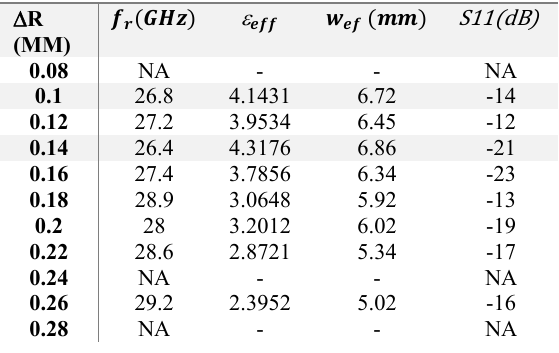
Table 1 . Effect of changing the deference between outer and